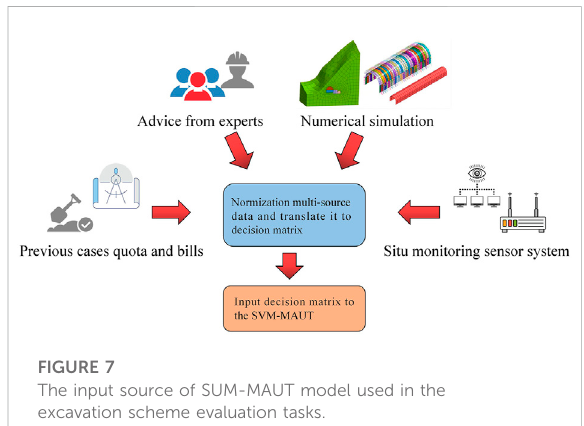
FIGURE 7 The input source of SUM-MAUT model used in the excavation scheme evaluation tasks.